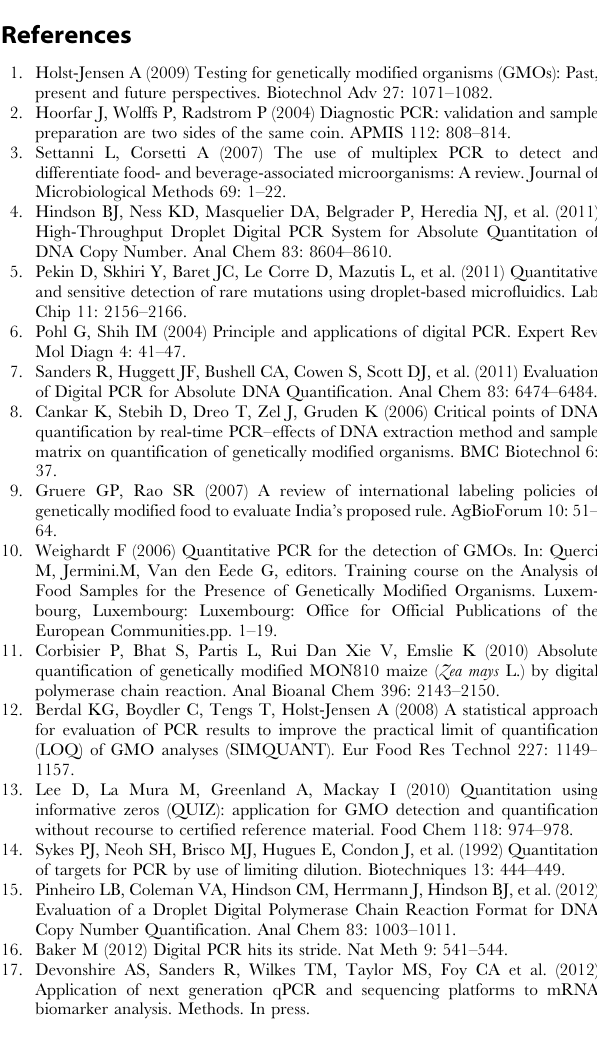
Table S3 Comparison of quantification using singleplex and duplex ddPCR assays. Table S4 Comparison of duplex ddPCR quantification on digested and non-digested genomic DNA. Table S5 Results from the dilution series used for the dynamic range, the aLOD and aLOQ determination, and the overall repeatability. Table S6 Inter- and intra-cartridge repeatability. (XLS) Table S7 False-positive rates observed with